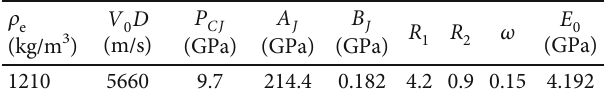
Table 2: Parameters of explosive material and JWL